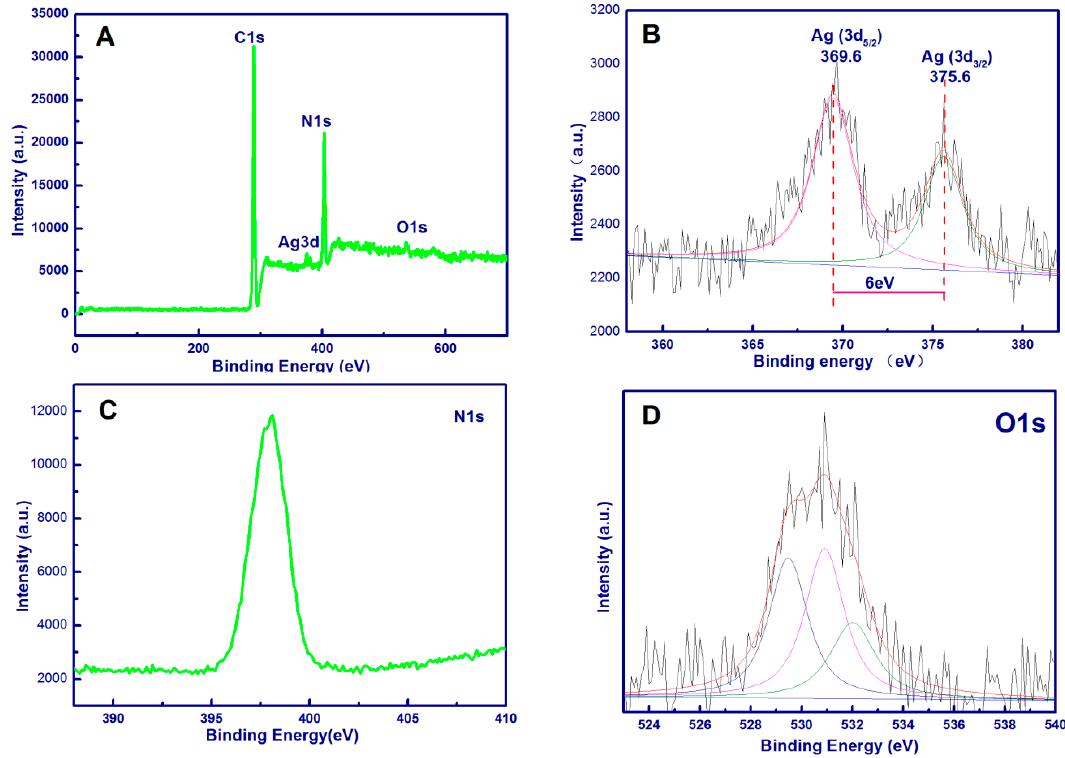
Figure 4. XPS full scan spectra of P-PAN/CNC/Ag nanofibers ( A ); the XPS spectra of Ag 3d ( B ); XPS spectra of N 1s ( C ); and XPS spectra of O 1s ( D ).